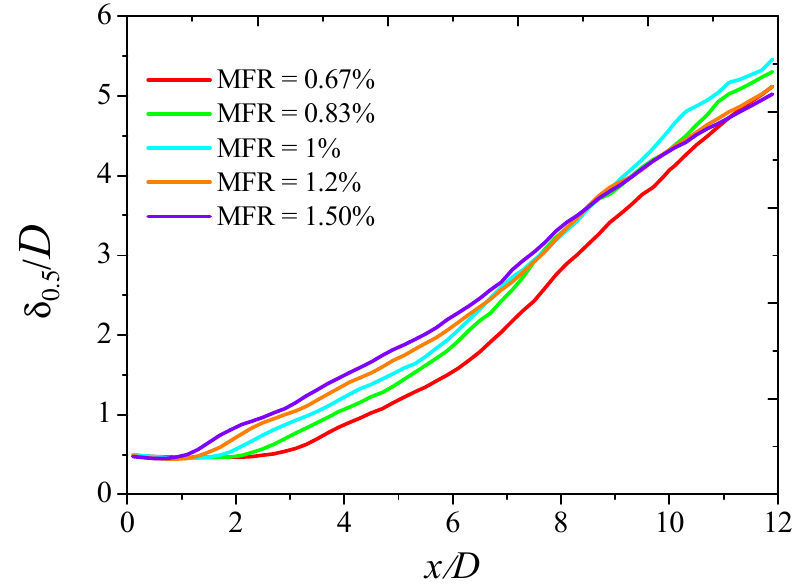
Figure 10. Jet half-width in the forced plane for different amplitudes.